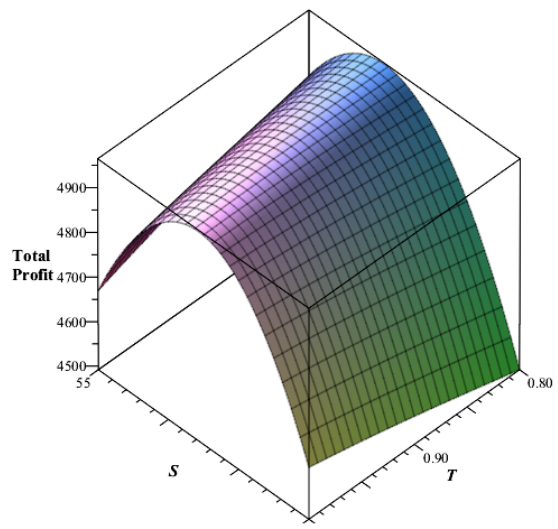
Figure 4. Optimality of a total profit function for situation 3 (0 < t n < T < M